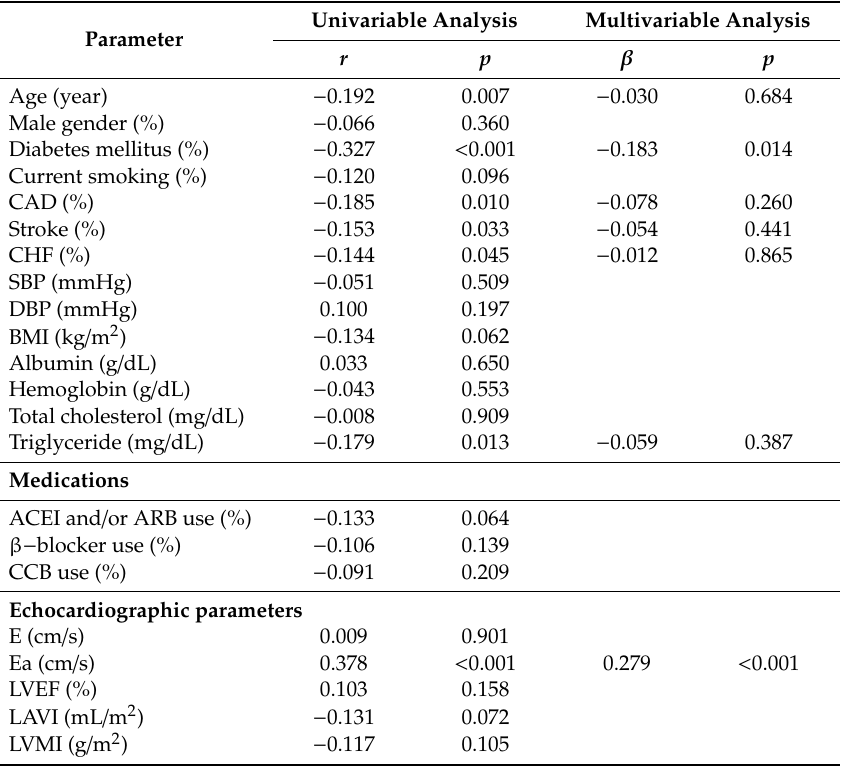
Table 2. Univariable and multivariable correlates of LA strain in study patients. Parameter